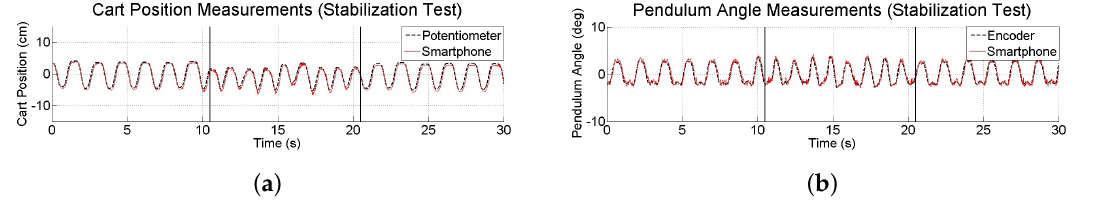
Figure 15. Experimental response of ( a ) cart position and ( b ) pendulum angle before, during, and after the use of vision-based measurements from the mounted